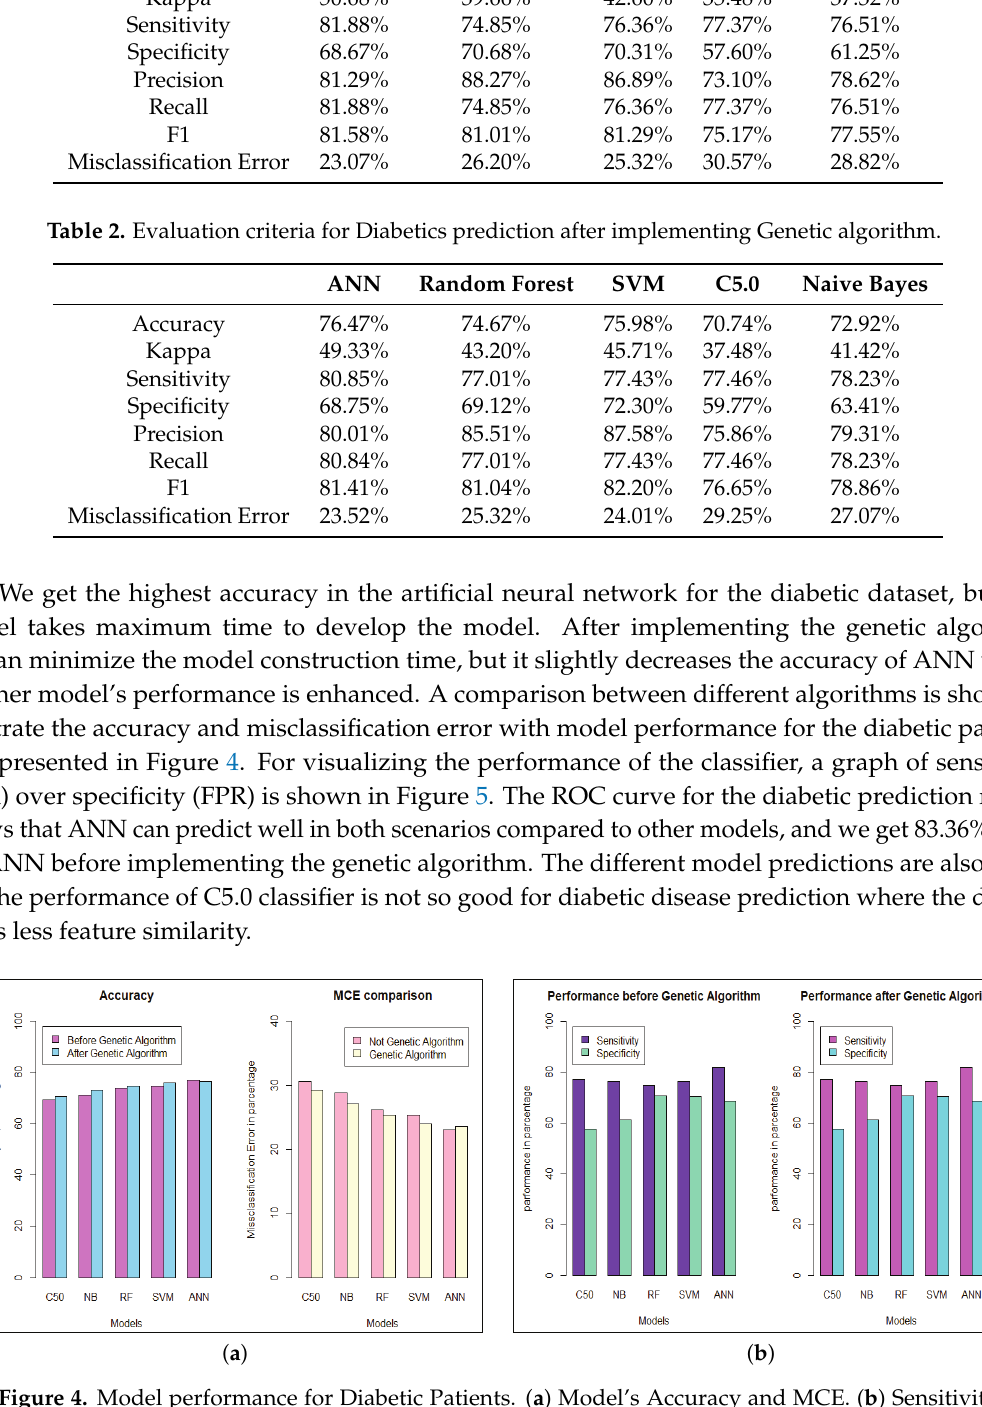
Figure 4. Model performance for Diabetic Patients. ( a ) Model’s Accuracy and MCE. ( b ) Sensitivity and Specificity